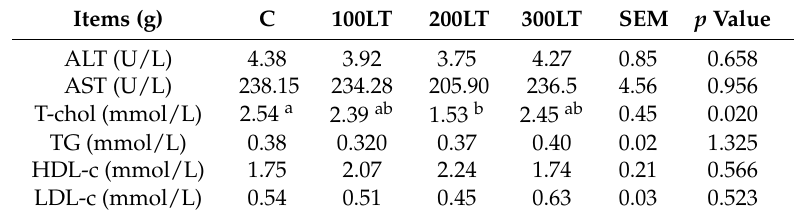
Table 6. Blood chemistry of broilers as affected by dietary L -theanine supplementation within 42 days of age. Items (g) C 100LT 200LT p Value